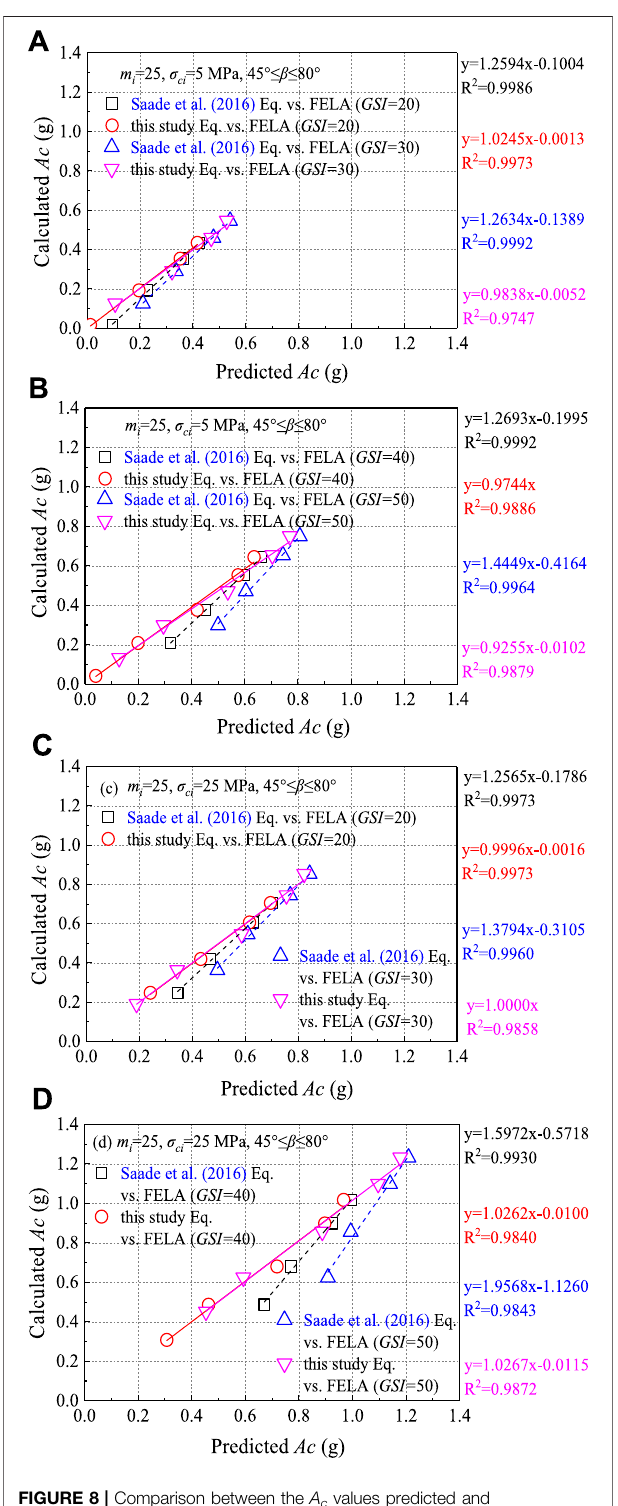
Frontiers in Earth Science |